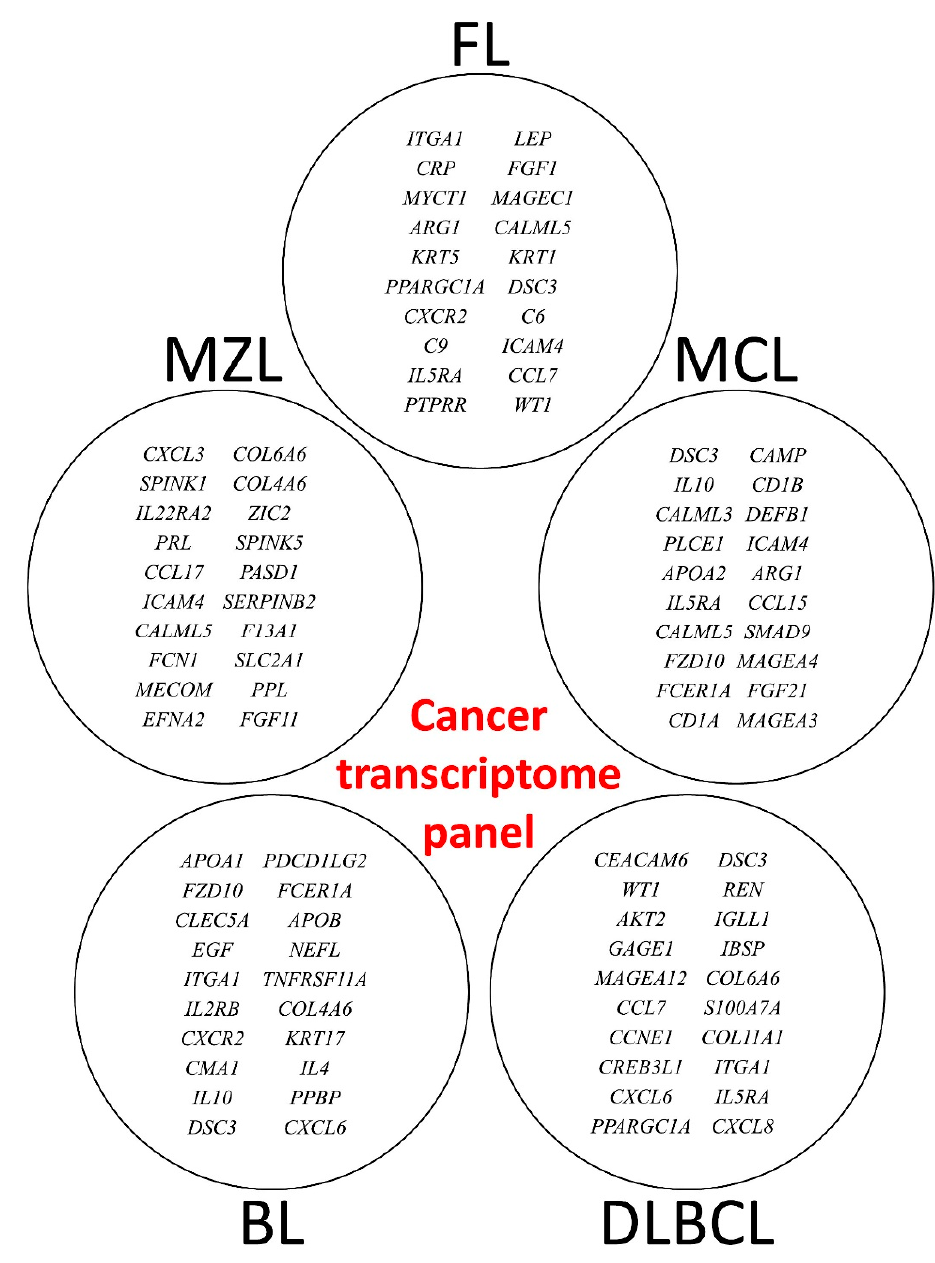
Figure 6. Prediction of each NHL subtype by the cancer transcriptome panel ( n = 1769) using MLP analysis. This figure shows the top 20 genes of the MLP analysis according to their normalized importance for predicting an NHL subtype against the other subtypes, using the cancer transcriptome panel. For example, ITGA1 was the most important gene for predicting FL vs. the other NHL subtypes (i.e., FL vs. MCL + DLBCL + BL + MZL).